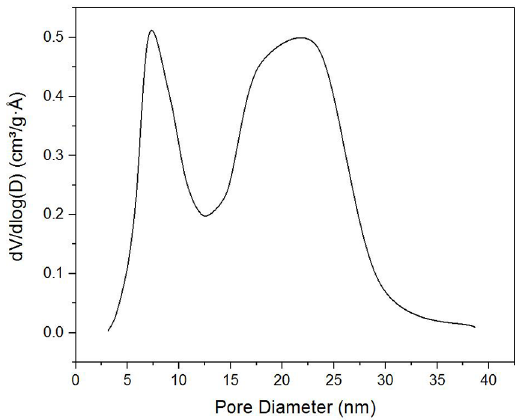
Figure 5. Distribution of pores sizes for the optimized